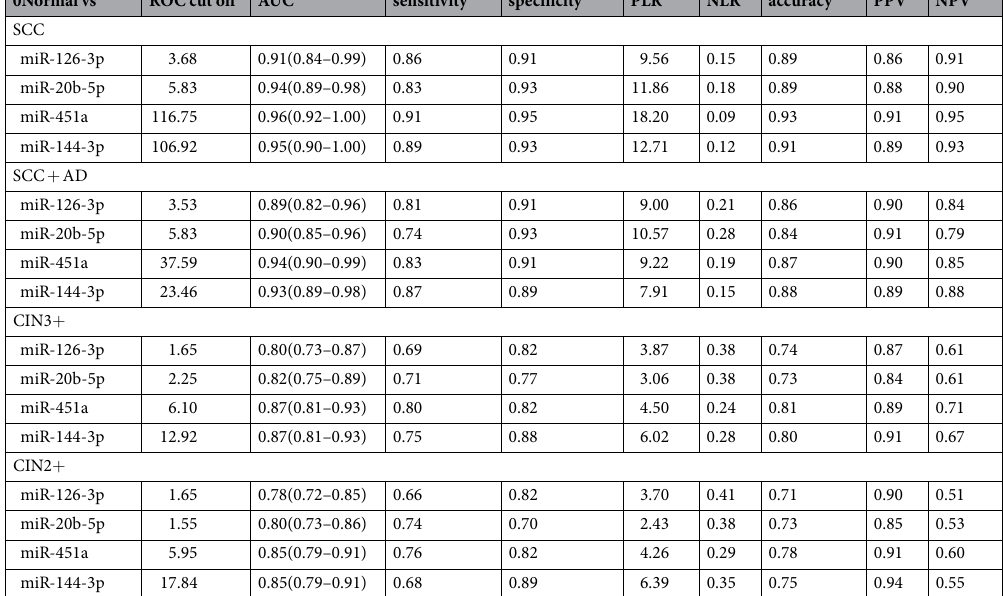
Table 2. Performance of the miRNA levels to detect cervical neoplasia. Note: ROC: receiver operating characteristic, AUC: area under the curve, PLR: positive likelihood ratio, NLR: negative likelihood ratio. PPV: positive predictive value, NPV: negative predictive value. The cut-off point was determined by the Youden index. Estimation of AUC: 1.0: perfect match, 1.0–0.9: high accuracy, 0.9–0.7: moderate accuracy, 0.7–0.5: low accuracy, 0.5: chance result 18